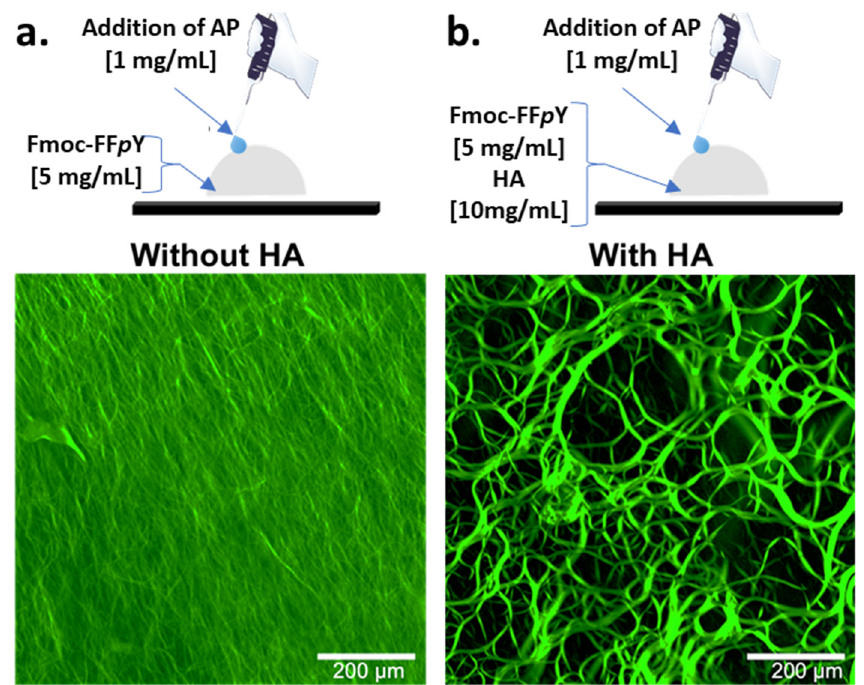
Figure 2. Fluorescence confocal microscopy images taken after the addition of AP (1 mg/mL) in Fmoc-FF p Y (5 mg/mL) borax buffered solution (25 mM, pH 9.5) containing Thioflavine T in ( a ) absence or in ( b ) presence of HA (10 mg/mL).